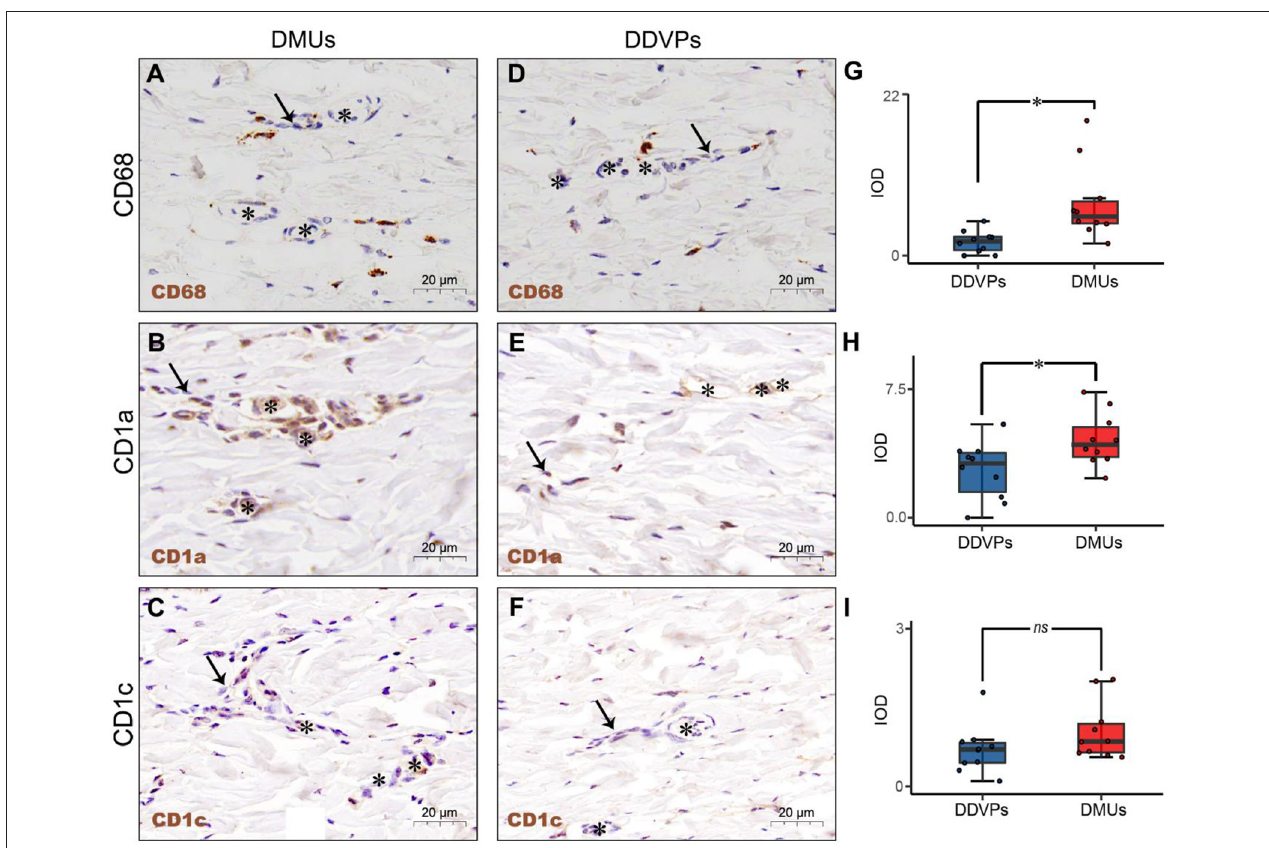
FIGURE 2 | The immunological structure of DMUs identified by IHC. (A) DMUs in pig cervical skin marked by CD68; (B) DMUs in pig cervical skin marked by CD1a; (C) DMUs in pig cervical skin marked by CD1c; (D) DDVPs in pig cervical skin marked by CD68; (E) DDVPs in pig cervical skin marked by CD1a; (F) DDVPs in pig cervical skin marked by CD1c; (G) CD68 + expression quantified by IOD in DMUs and DDVPs; (H) CD1a + expression quantified by IOD in DMUs and DDVPs; (I) CD1c + expression quantified by IOD in DMUs and DDVPs. (J) The anatomical location of DMUs in the skin and the structure of DMUs are presented in a schematic diagram. ns indicates no significant difference; * P < 0.05 indicates significant difference. Asterisks (*) point to microvasculature and arrows ( → ) point to capillary lymphatics; DMU, dermal microvascular unit; DDVPs, deep dermal vascular plexus; IOD, integrity optical density; scale bar (A–E) = 20 µ